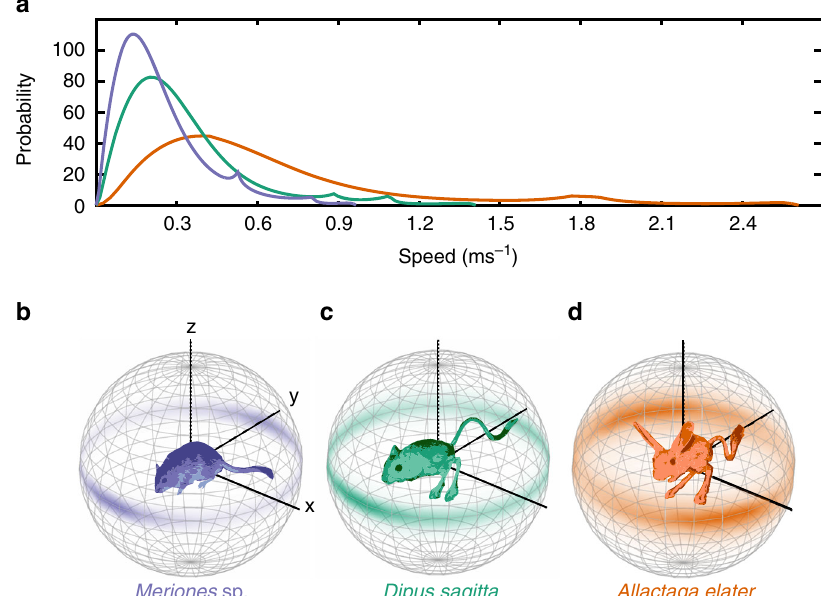
Fig. 4 Differences in unpredictability between species result from species-speci fi c patterns of speed and direction of motion. Continuous probability distributions of a speed and b – d angle of locomotion for fi eld animals. In all subplots, the quadrupedal jird, Meriones sp ., is shown in blue , the bipedal jerboa, Dipus sagitta , is shown in green , and the bipedal jerboa, Allactaga elater , is shown in orange . In a , the integral of each probability distribution is equal to one. In b – d , the color opacity at a given angle on the sphere corresponds to the probability of moving at that angle, with respect to the animal location in the previous frame (the center of the sphere). b Shows the probability distribution of the quadrupedal jird, Meriones sp., movement angle in blue , c shows the probability distribution of the bipedal jerboa, Dipus sagitta , movement angle in green , d shows the probability distribution of the bipedal jerboa, Allactaga elater , movement angle in orange . Spheres are symmetric about the equator due to the symmetry of the ascent and descent about the apex of a leap. Asymmetry about the y axis in Allactga elater is likely the result of asymmetry in the predation